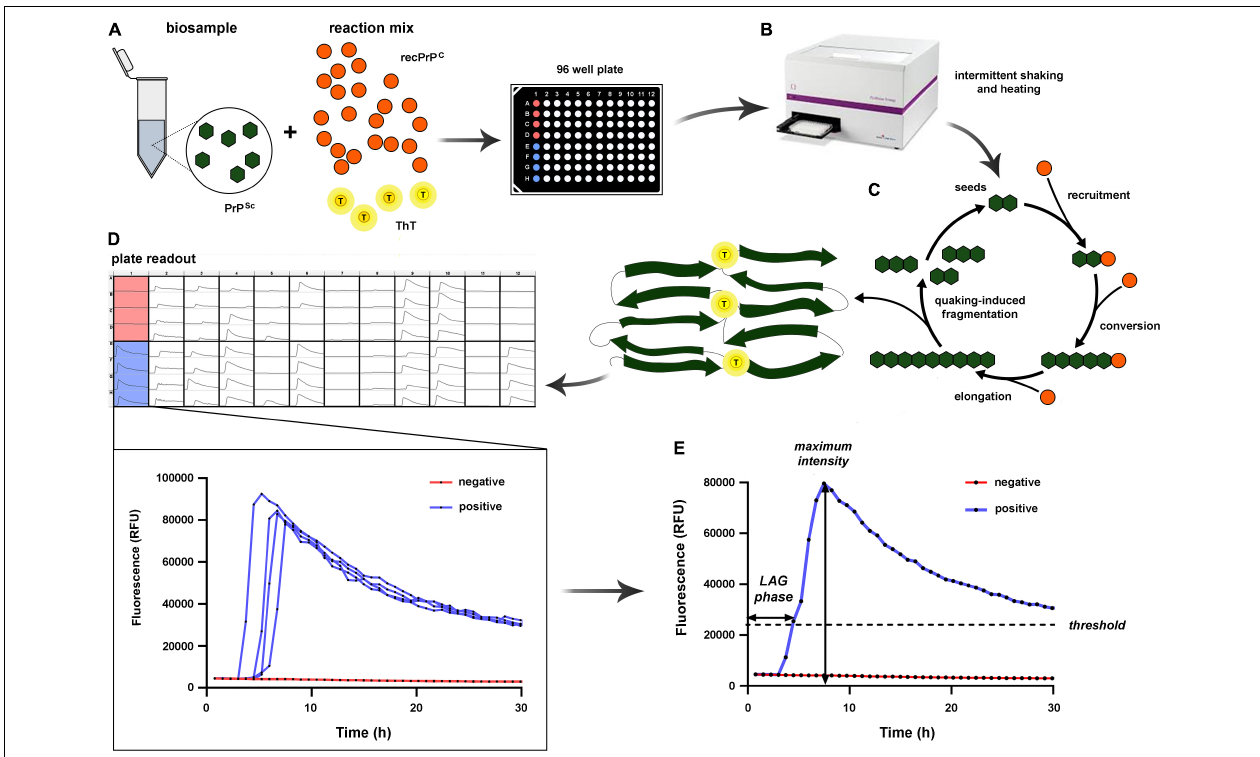
FIGURE 1 | Schematic illustration of the RT-QuIC assay. (A) The reaction mix includes the biosample to evaluate for the presence of PrPSc seeds, a relatively large amount of recombinant PrPC (recPrP C ), and thioflavin-T (ThT). (B) Each sample is loaded in quadruplicate (e.g., column 1, rows A–D are loaded with the same sample) in a 96-well plate; then the plate is incubated at a given temperature, and samples undergo intermittent rest/shaking cycles. (C) Overview of the reaction process: PrPSc seeds progressively elongate through recruitment and conversion of rPrP. The novel PrPSc oligomers are partially fragmented by quaking, producing novel seeds while, in part, they continue to elongate up to the status of protofibrils and eventually fibrils. By acquiring amyloid proprieties, the protofibrils/fibrils bind ThT, which produces a fluorescent signal monitored in real-time. (D) Plate readout at the end of the reaction. (E) On the left, quantitative evaluation of two exemplificative cases from column 1: lack of signal modifications over 30 h in A–D rows (negative sample, highlighted in red), and increase of fluorescent signal in E–H rows (positive sample, highlighted in blue). Each dot on the curves corresponds to a fluorescent signal reading. On the right, the positive and negative replicates are merged to show the two most significant kinetic parameters of the reaction, namely the LAG phase (time to reach the threshold) and the maximum intensity (the peak of the fluorescent